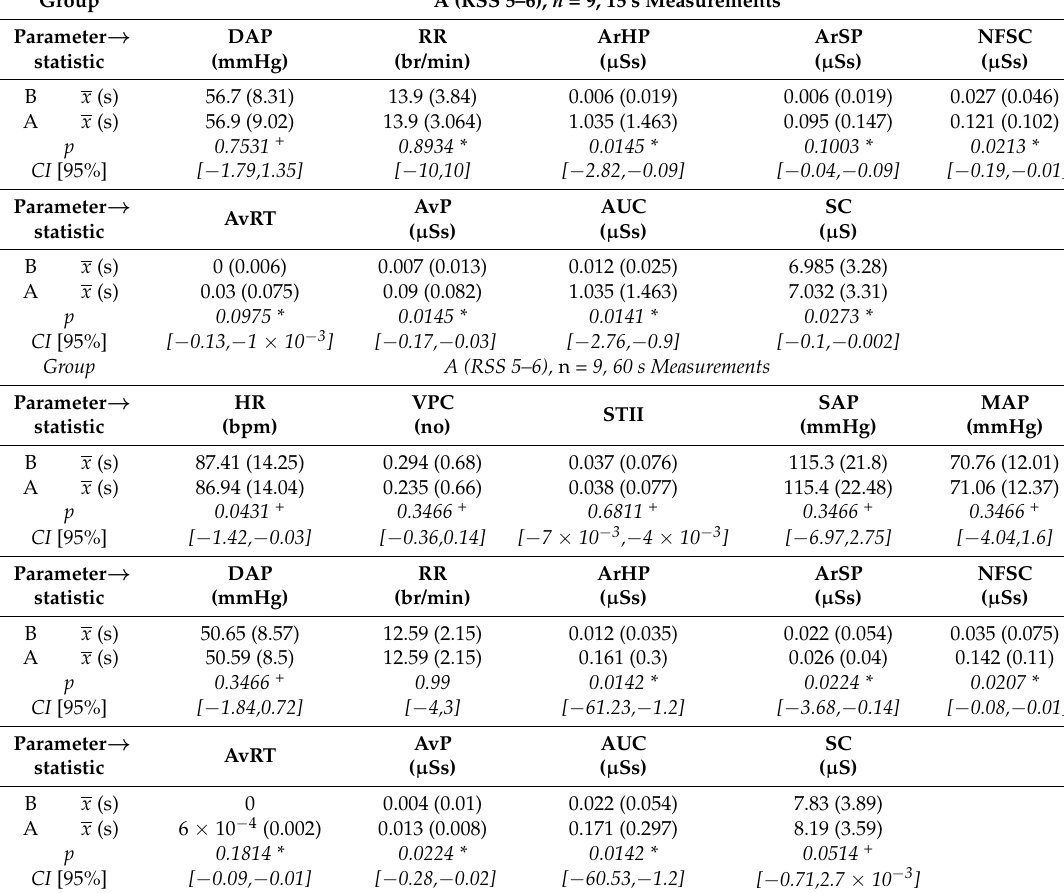
Table A2. Main descriptive statistics and before/after comparison of the measurements during suction in 60 s measurements for the two groups: HR—heart rate, VPC—ventricular premature